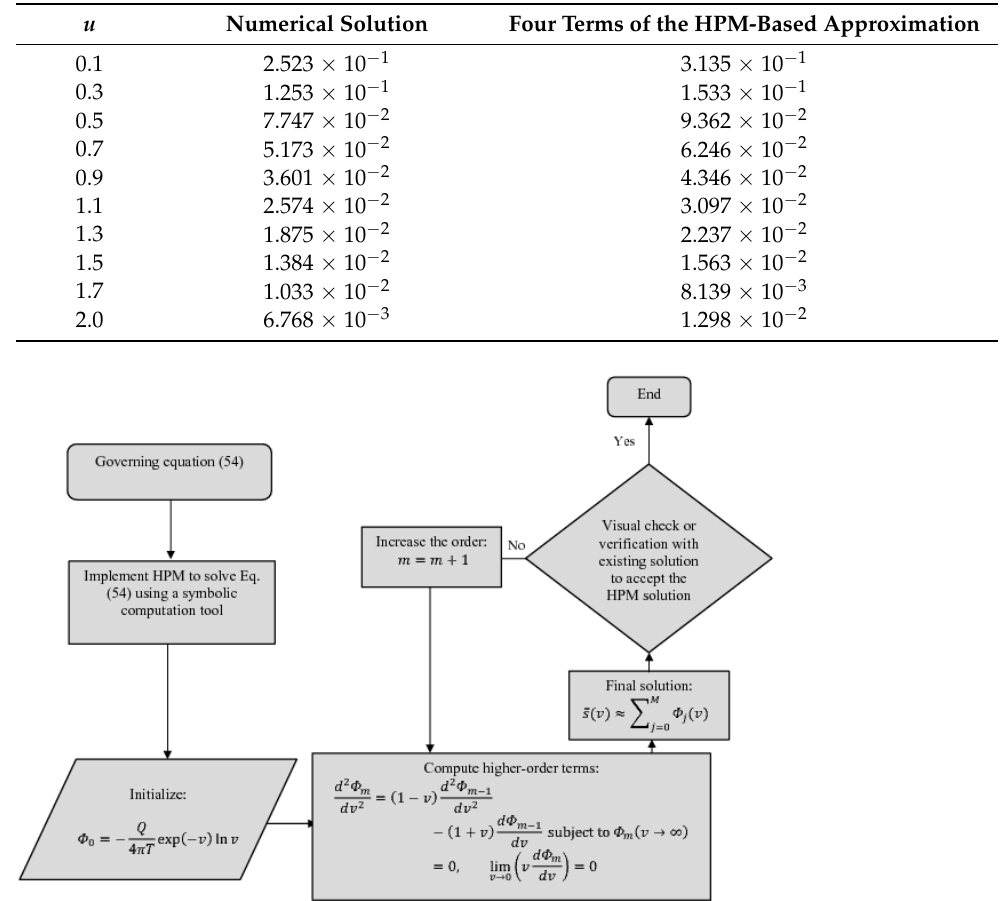
Figure 9. Flowchart for the HPM solution (78).